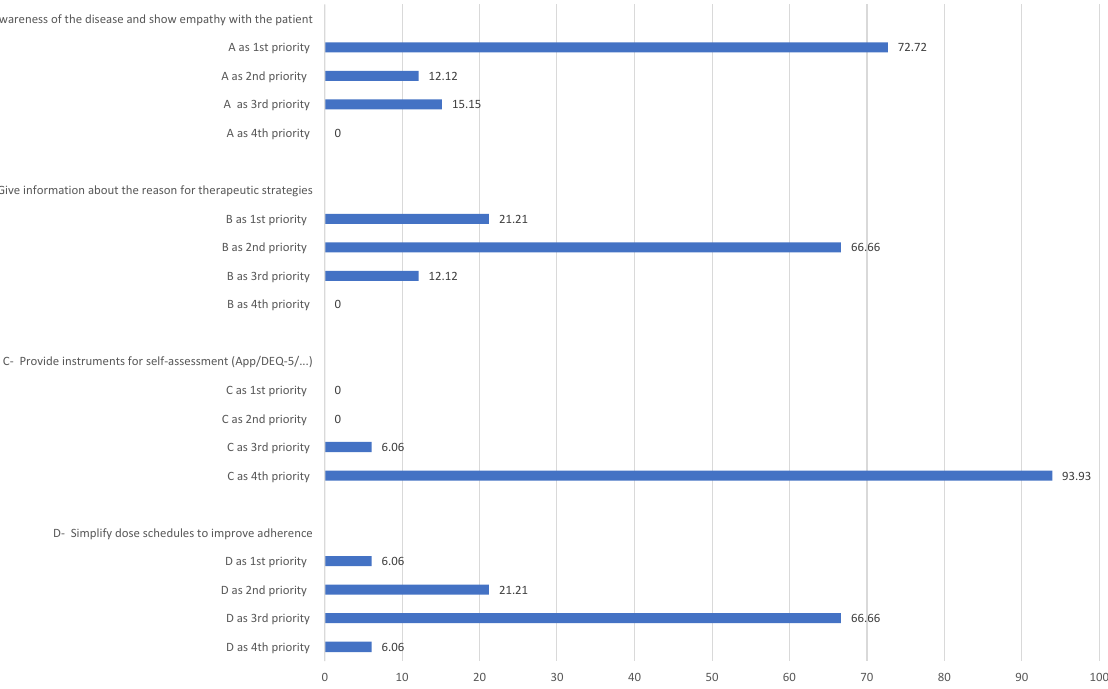
Figure 4. The ranking of the priorities attributed to the two statements related to improving patient satisfaction, collaboration and treatment